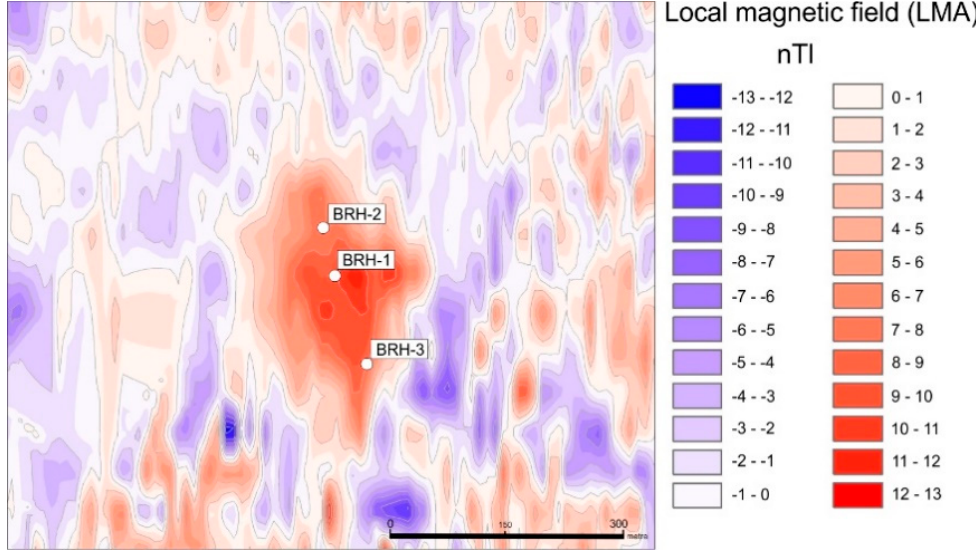
Figure 3. Map of local magnetic field (LMA) generated by a ground magnetic survey for the KL-01 pipe. The location of the KL-01 pipe is shown in Figure 2.